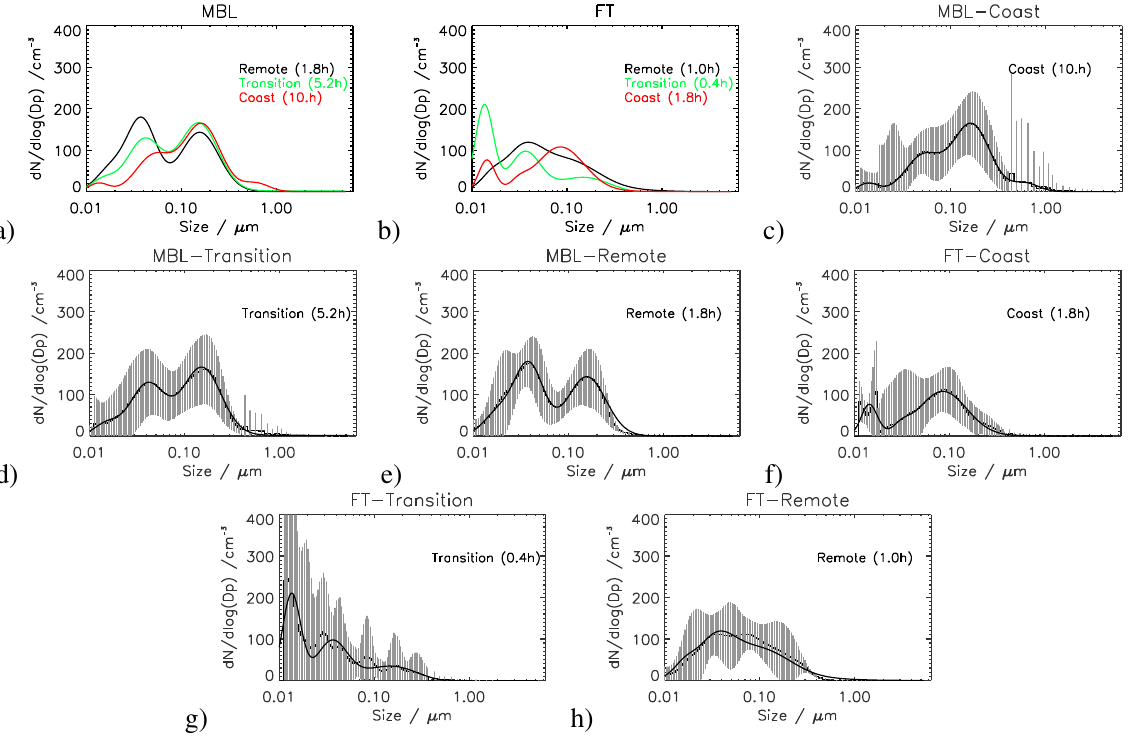
Fig. 12. Particle number size distributions (normalised to natural logarithm of bin width) and log-normal fitted functions between 10nm and 5µm in the MBL and FT as labeled, with total sampling time in hours in parentheses: (a) Log-normal fitted functions to median aerosol number spectra for each longitude zone labeled as coloured for the MBL; (b) Log-normal fitted functions for each longitude zone labeled as coloured for the FT; (c) Median MBL coastal zone spectrum (stepped grey line) with corresponding log-normal fit (solid black line); (d) Coastal zone FT spectrum; (e) Transition zone MBL spectrum; (f) Transition zone FT spectrum.; (g) Remote zone MBL spectrum; (h) Remote zone FT spectrum. For each sizing channel, grey bars illustrate one-standard-deviation of the measurement around the median in each channel. Stepped black lines define the median concentration in each sizing channel, whilst the smooth solid black line illustrates the corresponding log-normal fit.